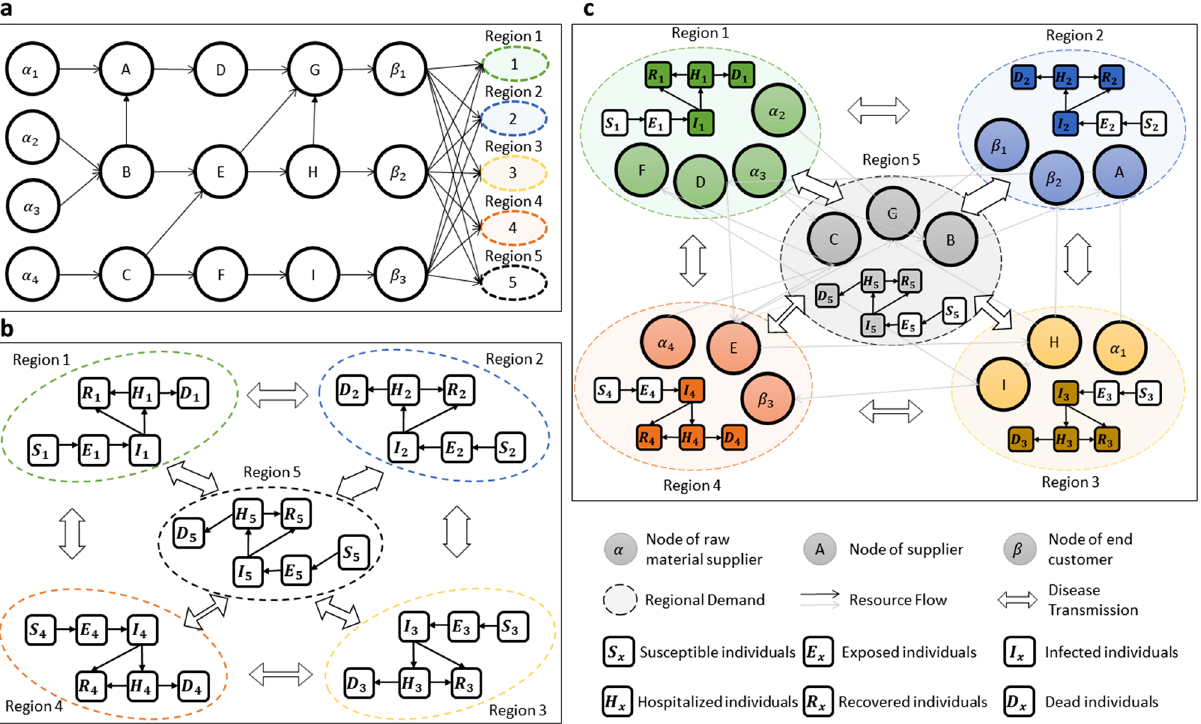
Figure 1. System Model of supply chain and disease dynamics: (a) a classic supply chain network with three types of products; (b) a classic multi-patch disease network for COVID-19; (c) the model of multi-patch disease and the production and supply